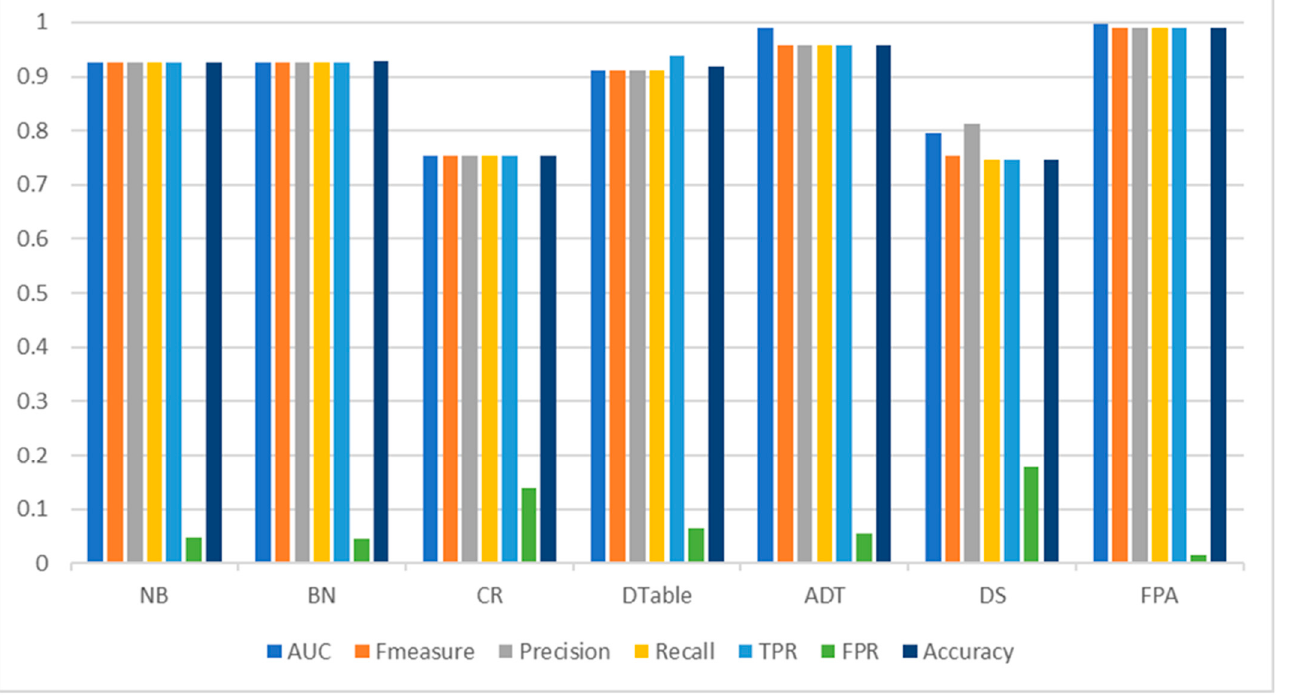
Figure 2. Android malware detection performance of FPA and baseline classifiers on the Malgenome dataset.